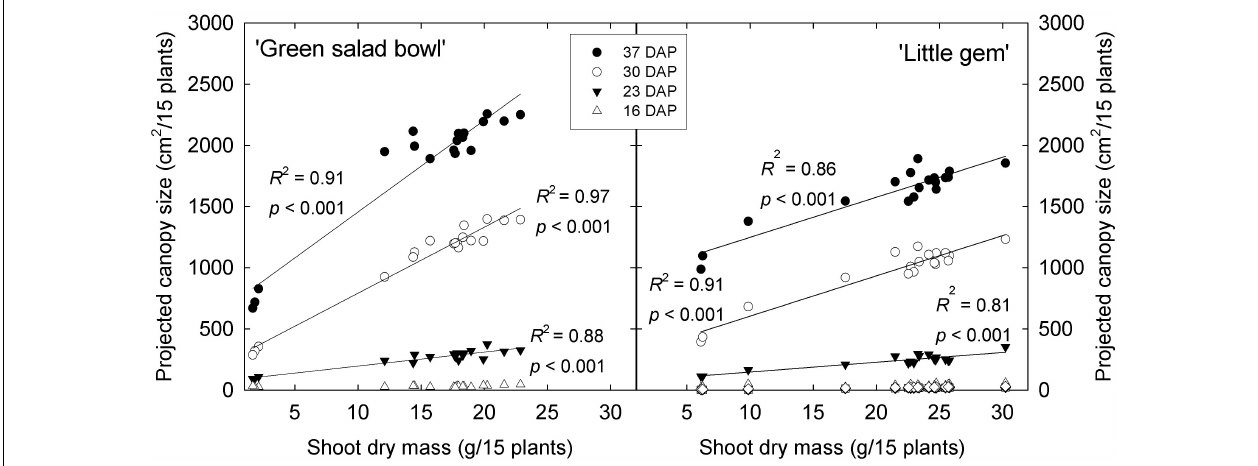
FIGURE 8 | Projected canopy size of ‘Green Salad Bowl’ and ‘Little Gem’ lettuce ( Lactuca sativa ) at 16, 23, 30, and 37 days after planting (DAP) vs. shoot dry mass of 15 plants. Symbols represent DAP. Plants were grown under fluctuating PPFD , with PPFD changing every 15 min between high and low intensities ( ∼ 400/0, 360/40, 320/80, 280/120, 240/160, and 200/200 µ mol · m − 2 · s − 1